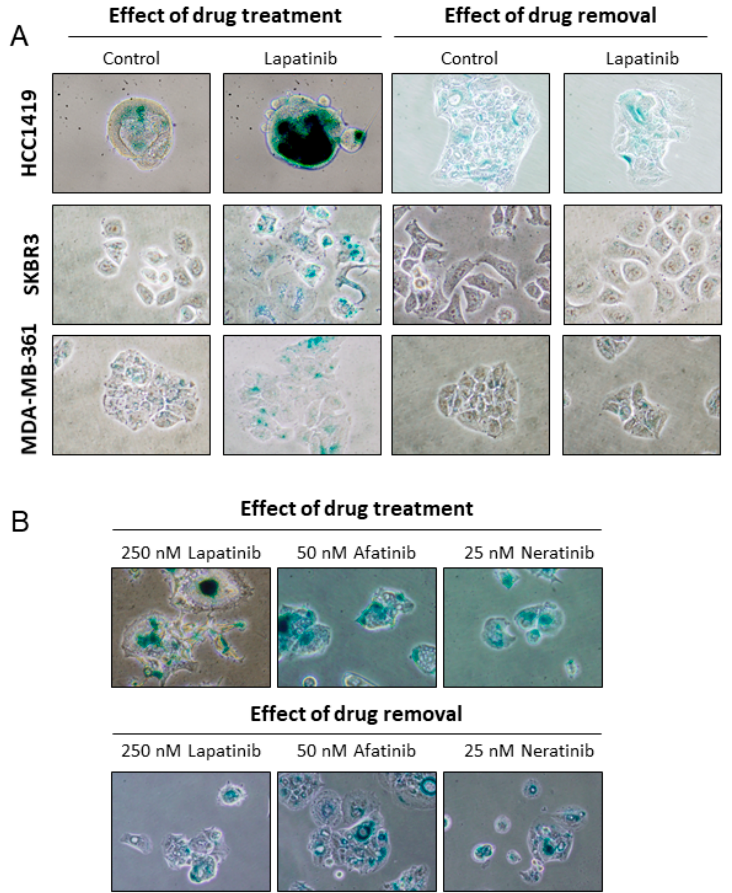
Figure 5. ( A ) HCC1419 cells were treated with 250 nM for 1 week, EFM-192A and SKBR3 cells were treated with 250 nM for 2 weeks and MDA-MB-361 cells were treated with 500 nM lapatinib for 4 weeks. Senescent cells were then cultured in the absence of lapatinib for 1 week prior to SA- β -gal activity testing. ( B ) HCC1419 cells were treated with the indicated concentrations of lapatinib, afatinib or neratinib for 1 week; the cells were then cultured in the absence of drug for two weeks prior to SA- β -gal activity testing. Images taken at 400× magnification.